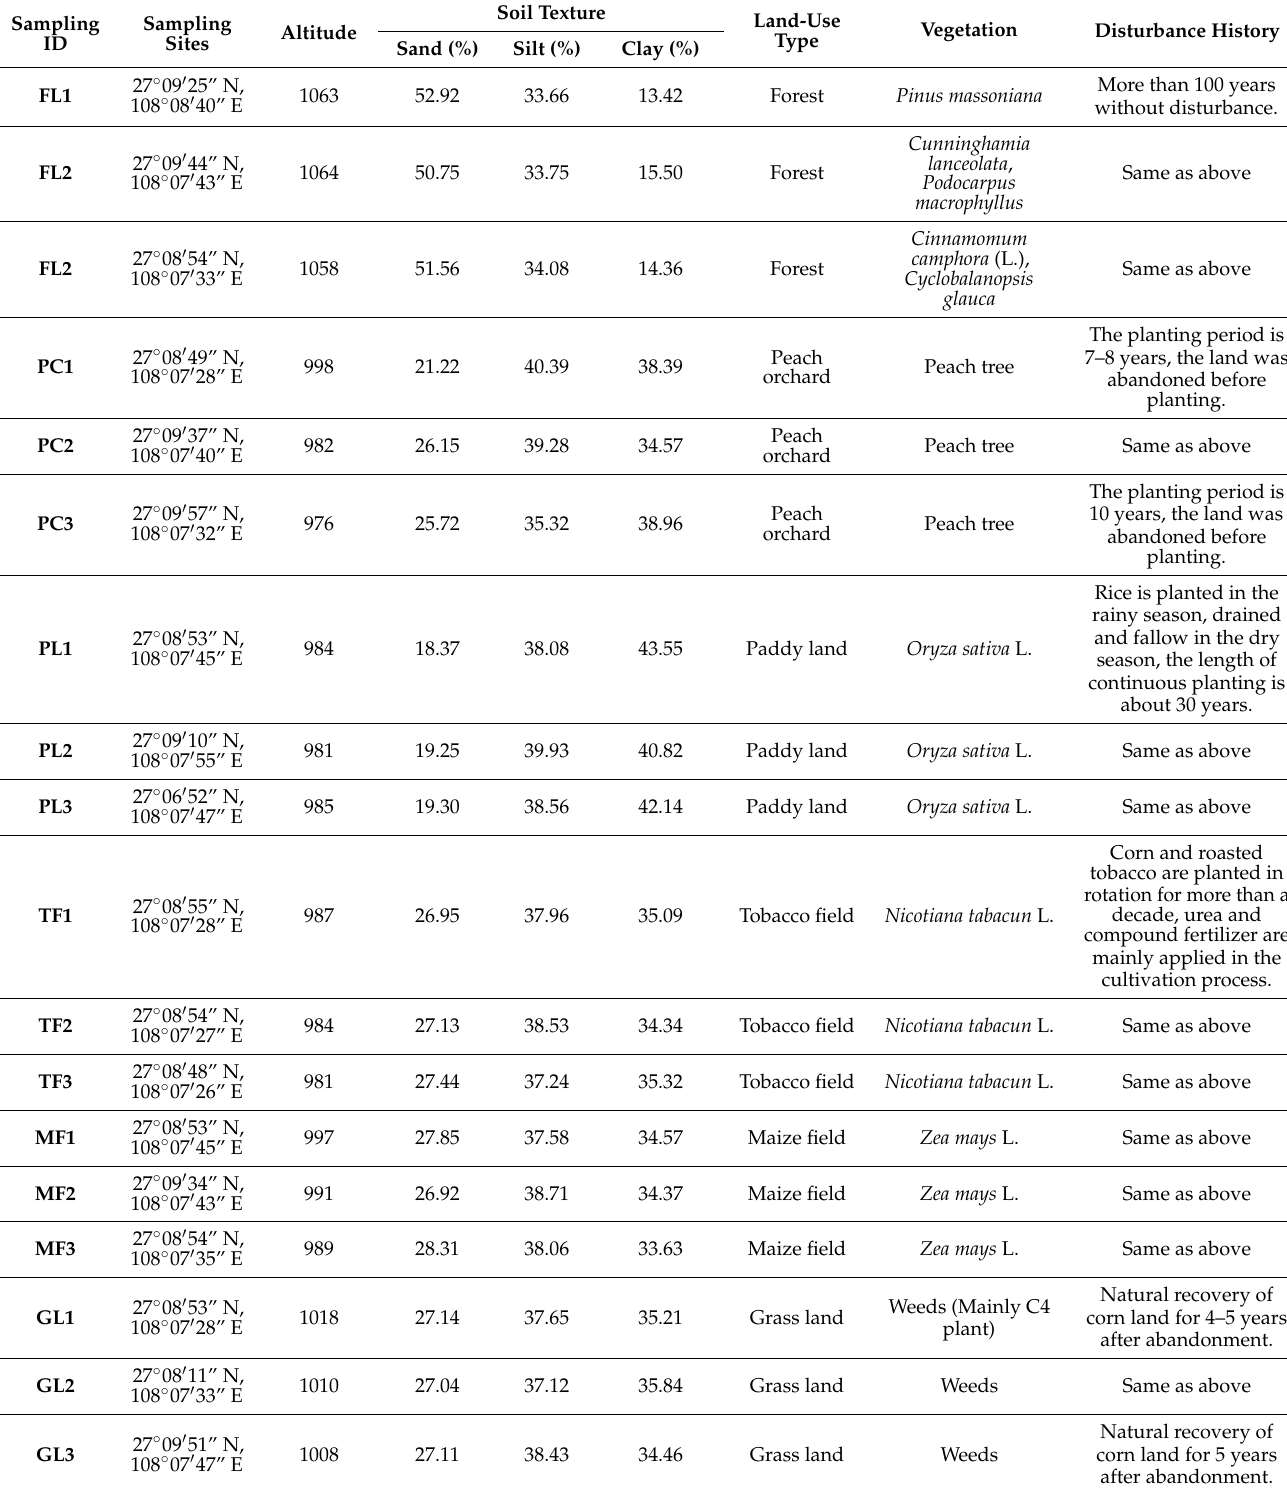
Table 1. General description of the sampling points at Shibing,